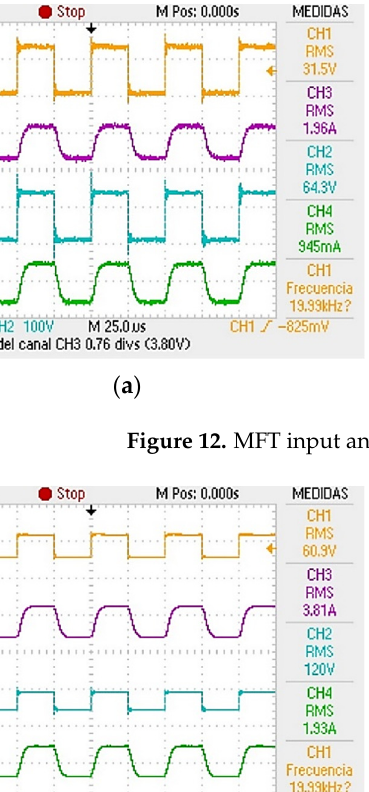
Figure 11. Block diagram of the experimental setup: ( a ) a DC variable source 0–120 V, ( b ) H Bridge